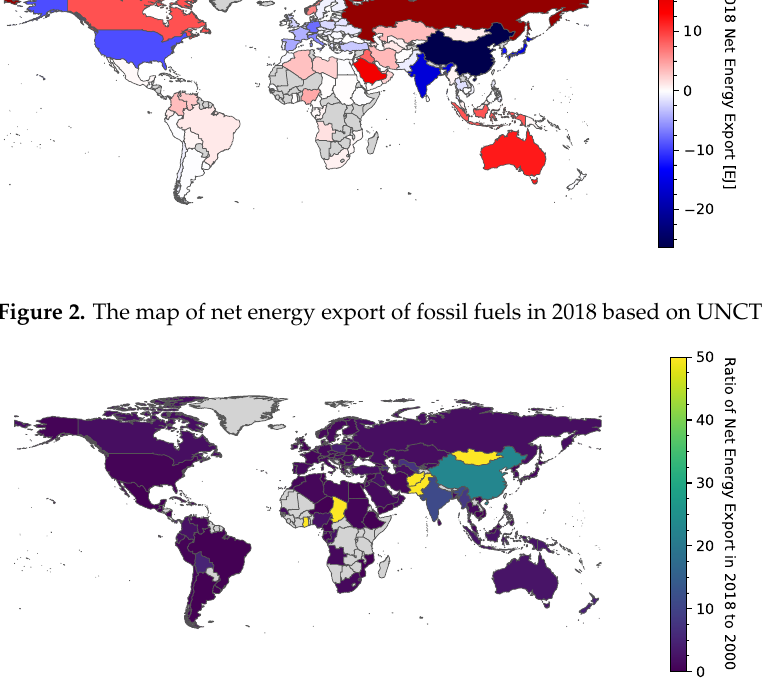
Figure 3. The ratio of net energy exports in 2018 to 2000 (below) based on UNCT